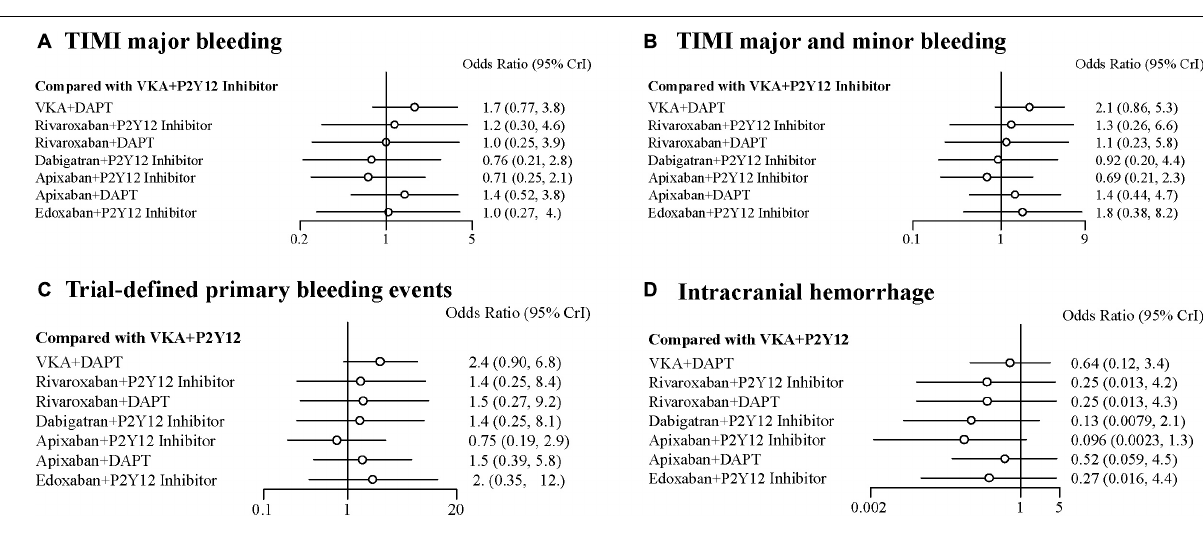
plus DAPT, 0.13 (95% CrI, 0.01–4.30) for dabigatran plus P2Y12 inhibitor, 0.10 (95% CrI, 0.00–1.30) for apixaban plus P2Y12 inhibitor, 0.52 (95% CrI, 0.06–4.50) for apixaban